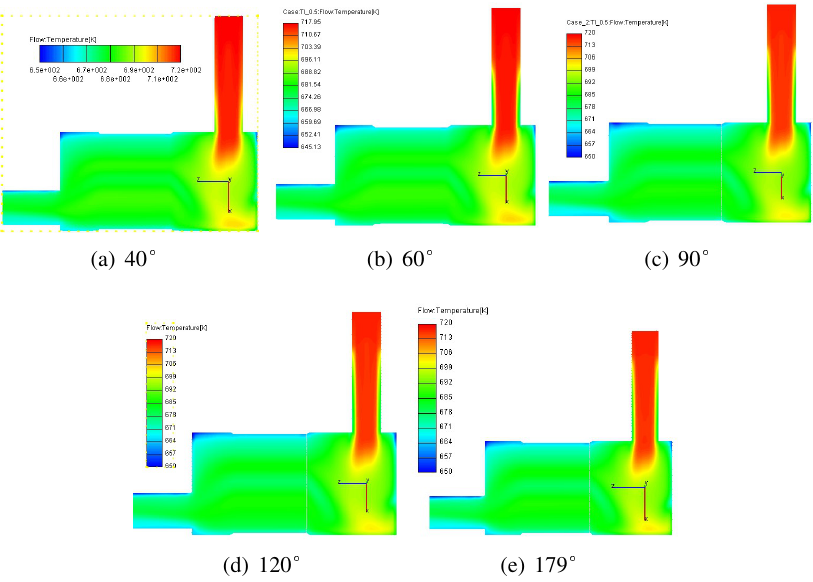
Fig. 7 Temperature distribution at different injection angles (Y section).